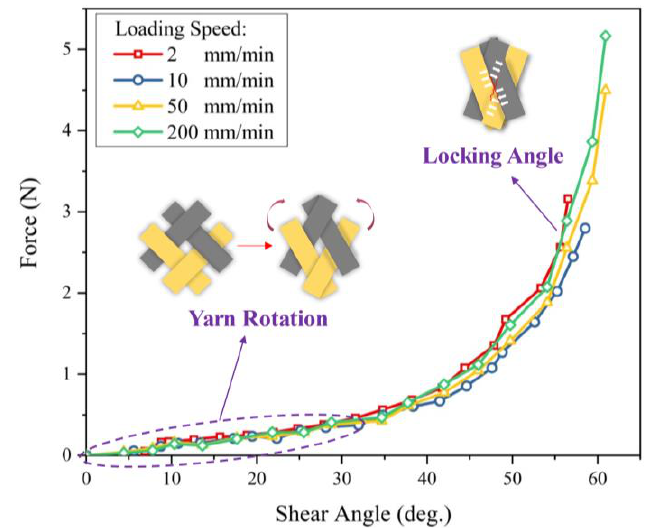
Figure 9. Force-shear angle curves at different loading speeds in bias-extension test.